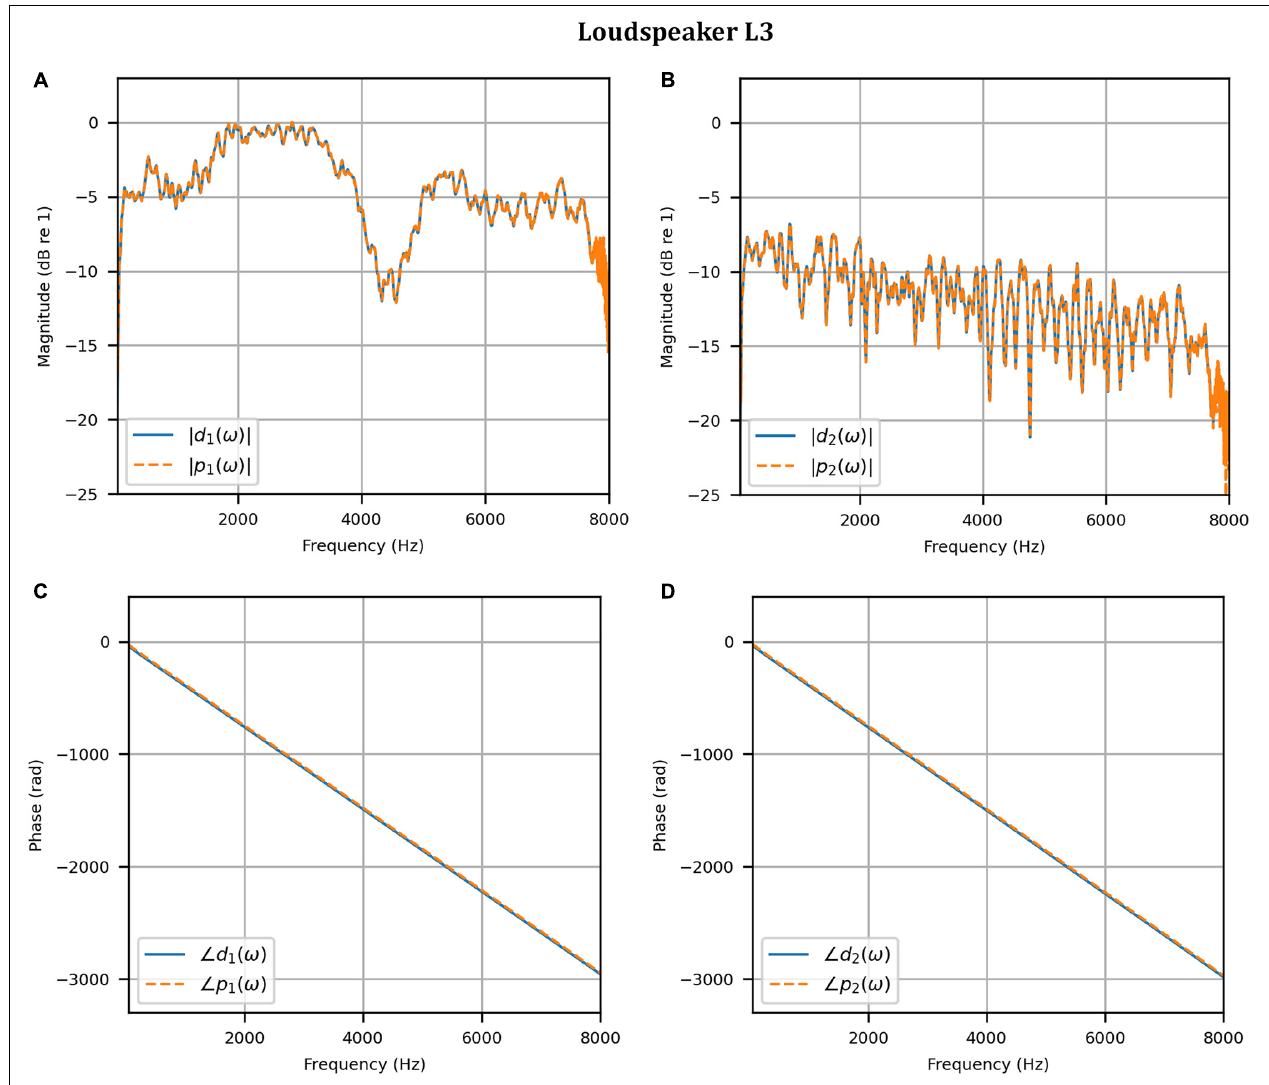
FIGURE 6 | Anechoic chamber: Target (blue solid) versus reproduced (red dashed) frequency responses for the HADRTF due to loudspeaker L3: (A) Magnitude responses at the left microphone; (B) Magnitude responses at the right microphone; (C) Phase responses at the left microphone; (D) Phase responses at the right